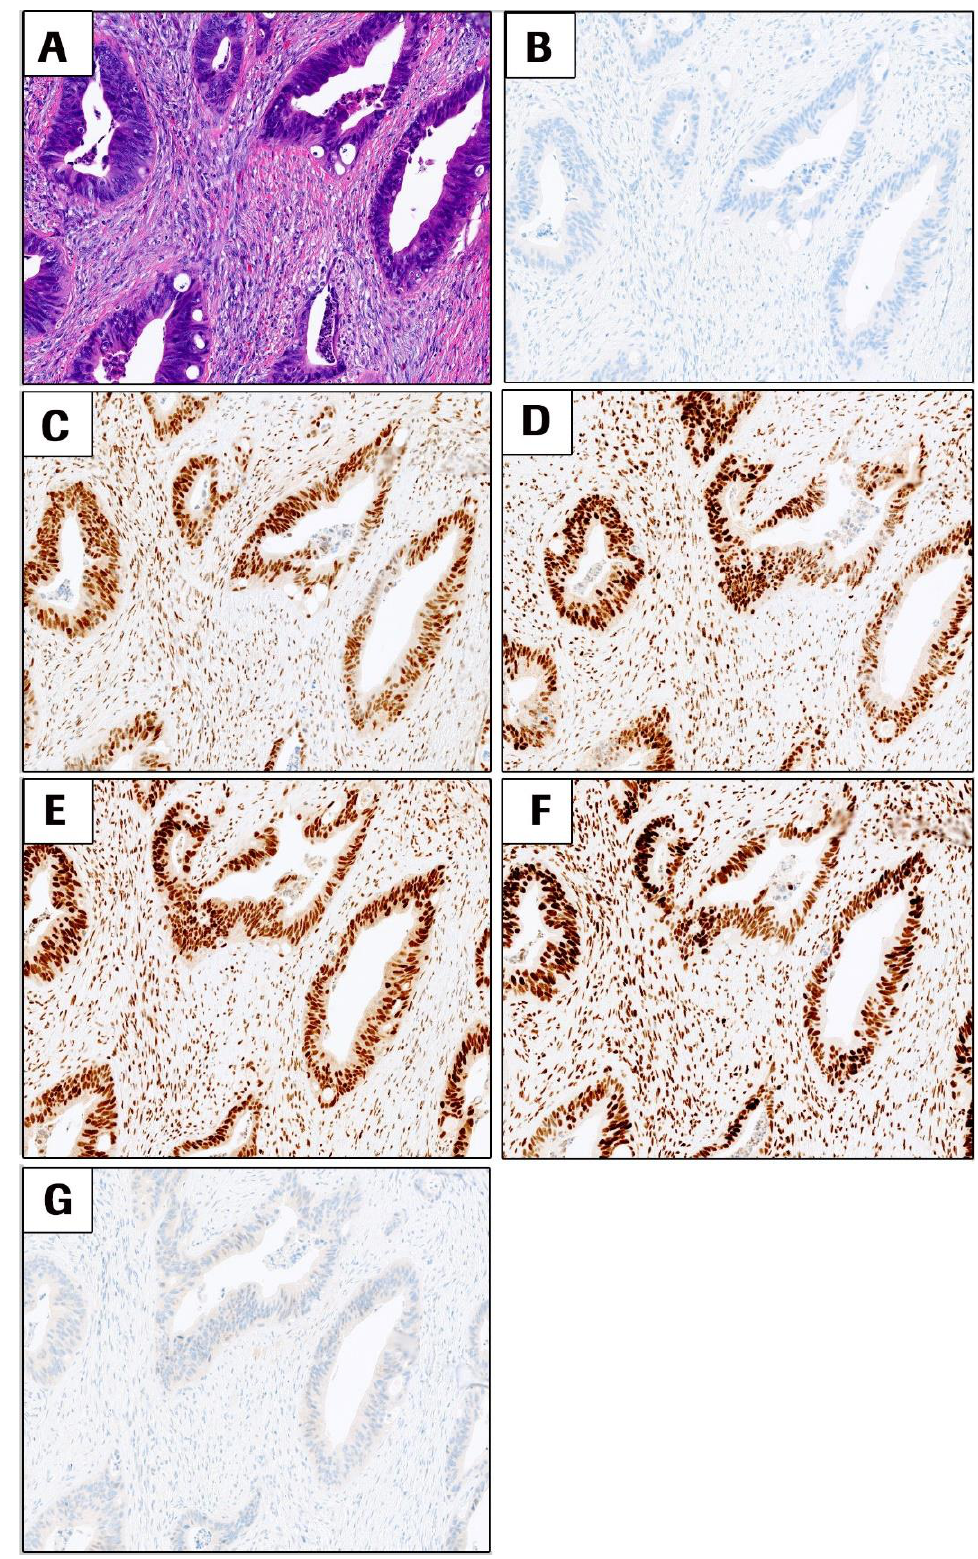
Figure 2. Representative images of a CRC case that exhibits proficient DNA mismatch repair status (pMMR) for all the four MMR markers in the VENTANA MMR IHC Panel and negative BRAF V600E. All images are at 10× magnification. ( A ) H&E, ( B ) negative control antibody, ( C ) MLH1, ( D ) PMS2, ( E ) MSH2, ( F ) MSH6, and ( G ) BRAF V600E staining. All images are at 10× magnification.